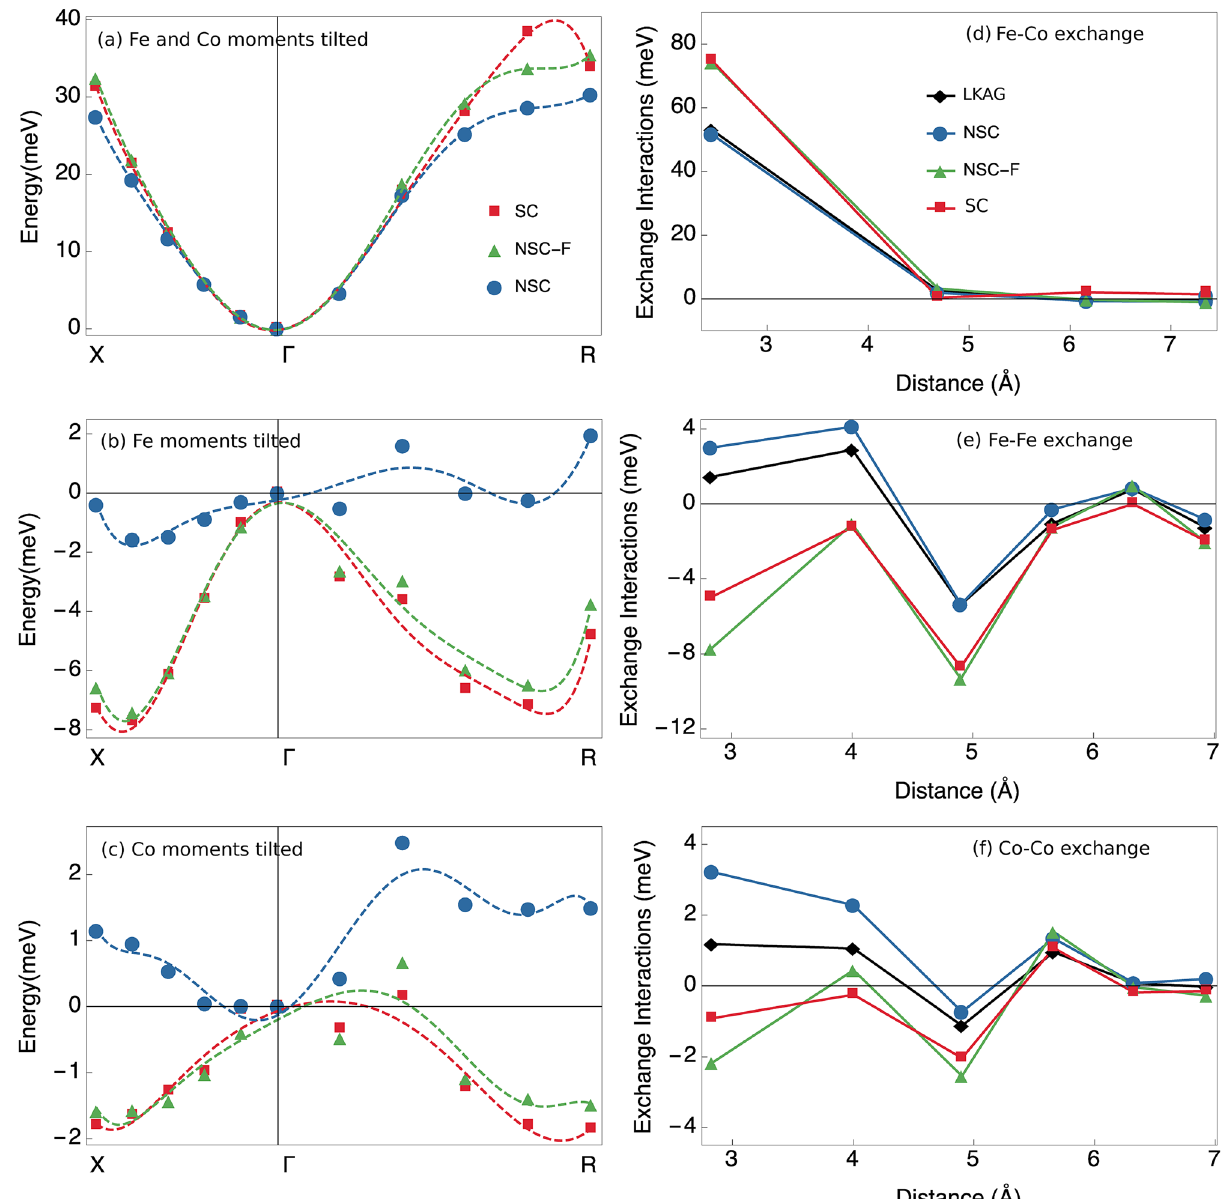
Figure 4. Spin-spiral energy dispersion curves in B2 FeCo, when: ( a ) both the magnetic moments on the Co and Fe sub-lattices are tilted, ( b ) with only the magnetic moments on the Fe magnetic sub-lattice tilted and ( c ) with only the magnetic moments on the Co magnetic sub-lattice are tilted. The blue circles and green triangles represent non-self-consistent total energies calculated without- (blue) and with (green) constraining fields. The red squares represent self-consistent total energies. Dashed lines represent fitted polynomials. Also shown are exchange interactions between: ( d ) the two magnetic sub-lattices, Fe and Co, ( e ) within the Fe magnetic sub-lattice and ( f ) within the Co sub-lattice. The green triangles and blue circles represent exchange parameters calculated non-self-consistently with (green) and without (blue) constraining fields. The red squares and black diamonds represent exchange parameters calculated with the transverse field method and the method of Lichtenstein et al. 9 , also obtained by KKR calculations using the Liechtenstein-Katsnelson-Antropov-Gubanov (LKAG) method 9 and found to be similar to the ones obtained by the conventional frozen magnon method (the black vs the blue symbols in Fig. 4d–f). Also previous KKR calculations by MacLaren et al. 59 match our KKR results well. This shows that the conventional MFT calculations fail to describe the self-consistent energy landscape of FeCo due to the LWA, regardless of the specifics of the implementation. In the case of FeCo, there is no experimental value to compare to, since this compound undergoes a structural phase transition before losing the magnetic ordering.